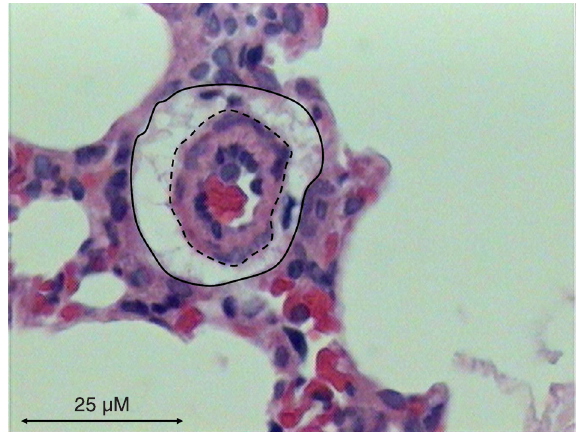
Figure 1. Digitized small caliber vessel with surrounding perivas- cular edema analyzed with the Image Tool software. The perivas- cular edema index (PEI) was obtained according to the formula PEI = perivascular edema area / vessel area. Magnification = 400X; Bar = 25